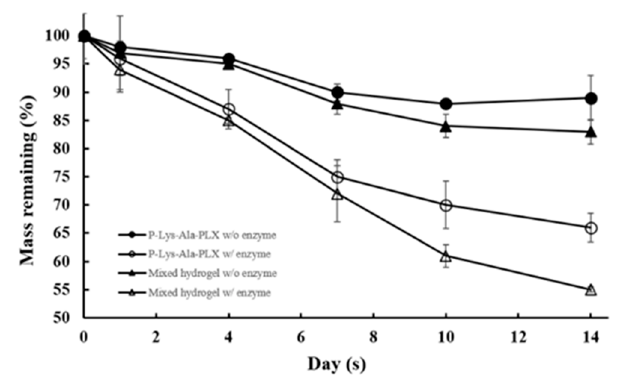
Figure 5. Degradation profiles of P–Lys–Ala–PLX and sample 5:1 mixed hydrogel in phosphate-buffered saline (PBS) with or without 5 U/mL elastase ( n = 6).